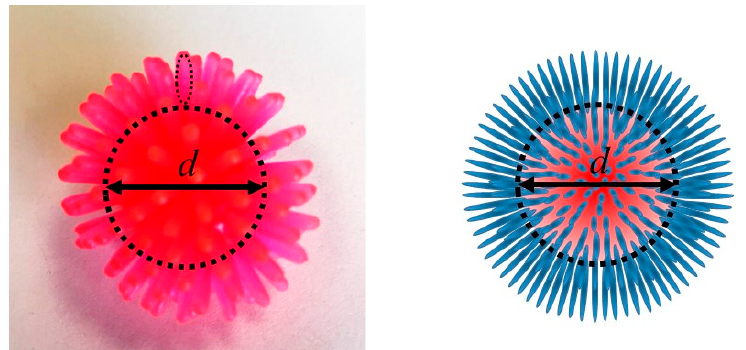
Figure 4. A picture of an illustrative model and sketch demonstrating a peptide aligning over the surface of a gold colloidal particle with a diameter, d . In the image on the left, the peptide and gold core are both shown with the same color, and a dotted oval indicates a prolate shaped peptide. In the sketch on the right, prolate shaped peptide is shown in blue and the core gold colloid with diameter d is shown in red sphere.